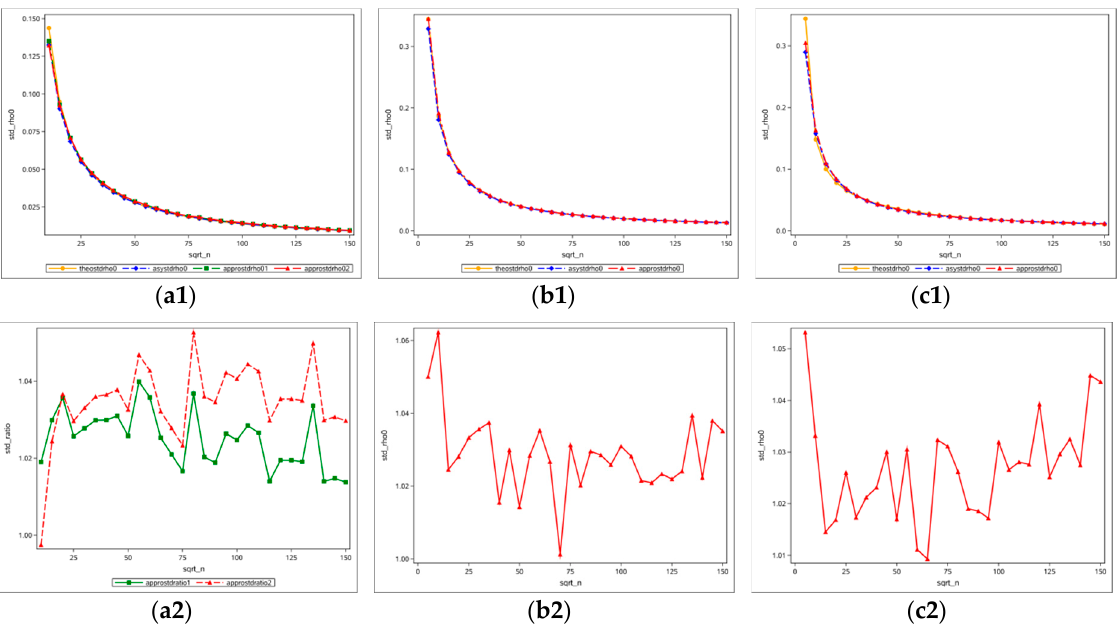
Figure 6. Convergence and variance ratio plots at ρ = 0. ( a1 , a2 ) Square rook variance convergence and ratio plots; ( b1 , b2 ) square queen variance convergence and ratio plots; ( c1 , c2 ) hexagonal variance convergence and ratio plots.